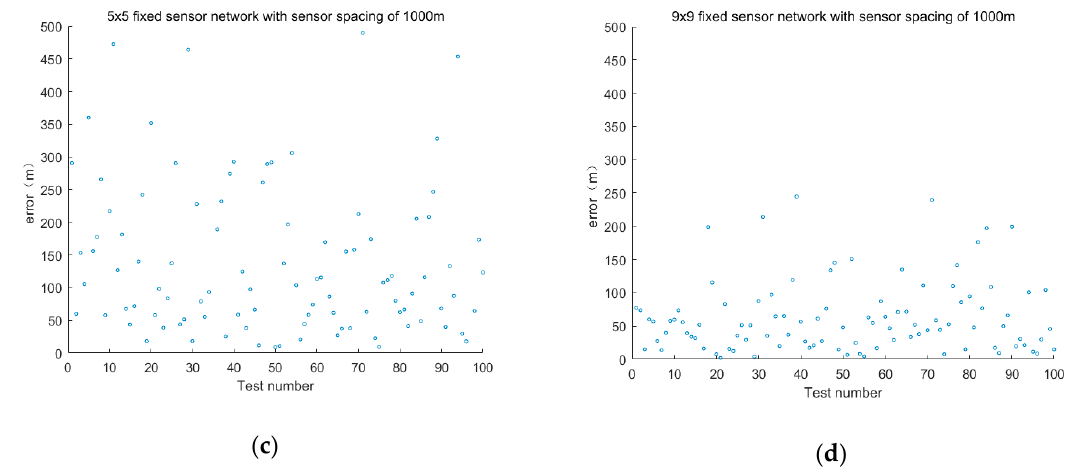
Figure 6. Positioning error of fixed sensor networks with different layouts at 1000 m intervals.